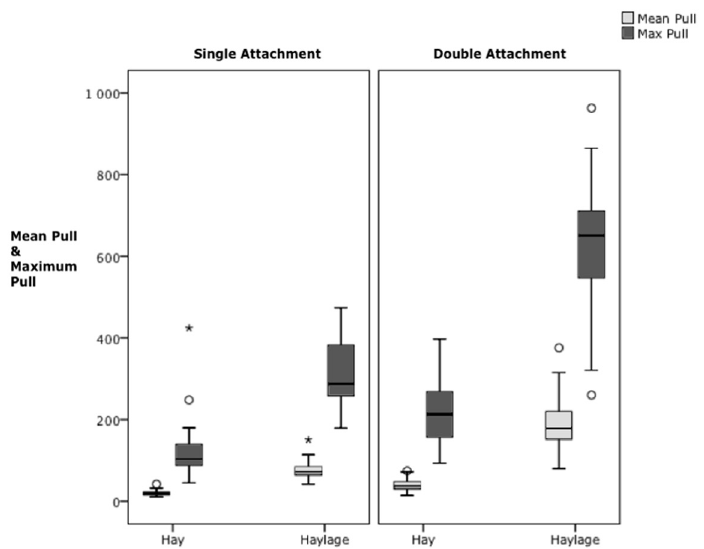
Figure 6. Overall distribution of pull pressure when eating from haynets either from the single attachment or double attachment (mean-grey and maximum-black force) for all horses (n = 10) and all sessions (n = 155), split across the forage treatment type (hay n = 79; haylage n = 76). (Note pressure from double attachment was rigged via a pully system onto the top gauge, making it inclusive of readings from the bottom gauge). All measures within same units differed significantly (Hay single versus Hay double p < 0.05; all others p < 0.001, Anova, *, o = outliers). For single attachment data, there were significantly higher mean (Mean HG 74.2 ± 16.5 N, HY 20.5 ± 5.6 N, F = 95.3, p < 0.001, Anova), maximum and median pull pressures when eating haylage compared to hay. Comparing pulls according to pressure ranges also showed significantly higher occurrence of pulls >50 N for haylage and significantly higher numbers of pulls below 30 N ( p < 0.001) for hay (Figure 7).